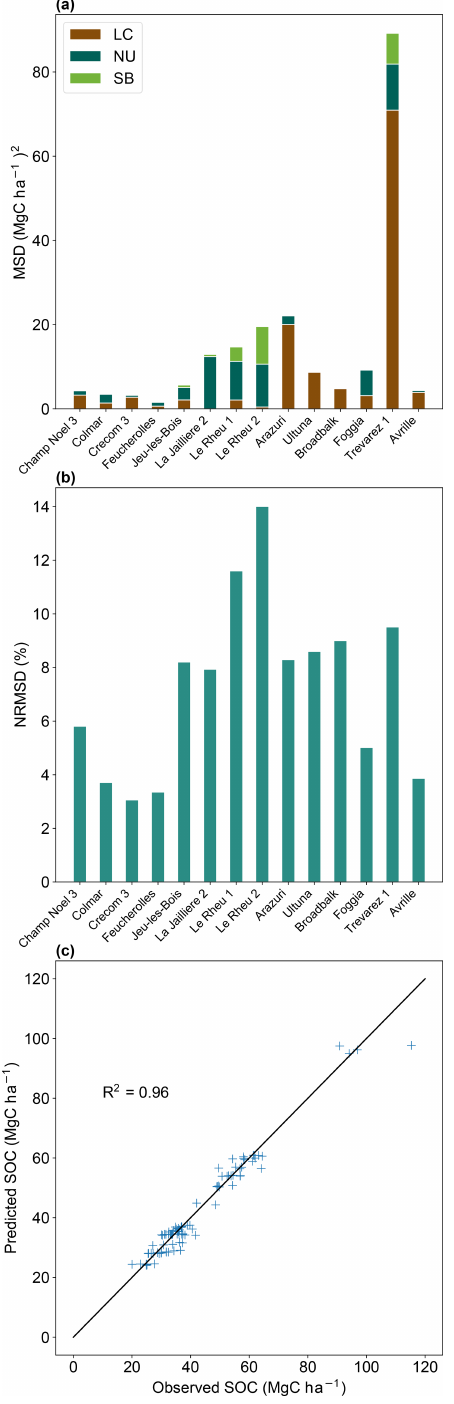
Figure 4. (a) Decomposed mean squared deviation ( MgCha − 1 ) 2 in control plots for all sites. LC: lack of correlation; NU: non-unity slope; SB: squared bias. (b) Normalized root squared deviation (%) in control plots for all sites. (c) Fit of predicted vs. observed SOC stocks (MgCha − 1 ) to control plots for all sites ( R 2 = 0.96).